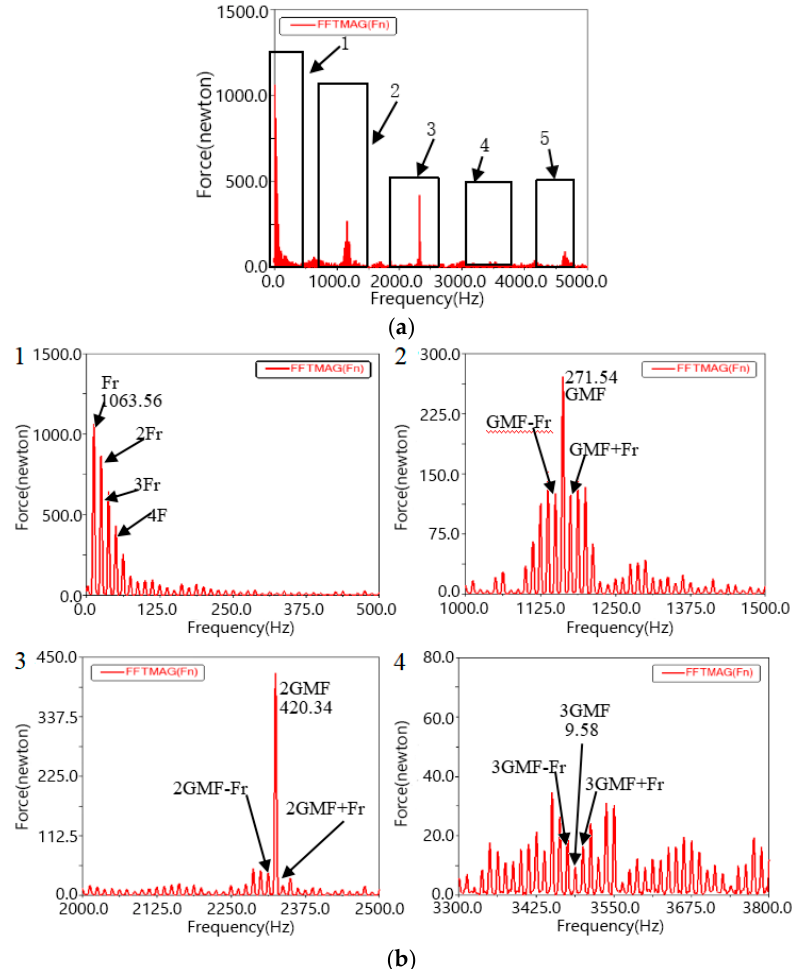
Figure 11. Full broken tooth: ( a ) frequency spectrum of normal meshing force; ( b ) zoom magnified images of positions 1–4 of ( a ) (position 5 has the similar distribution).